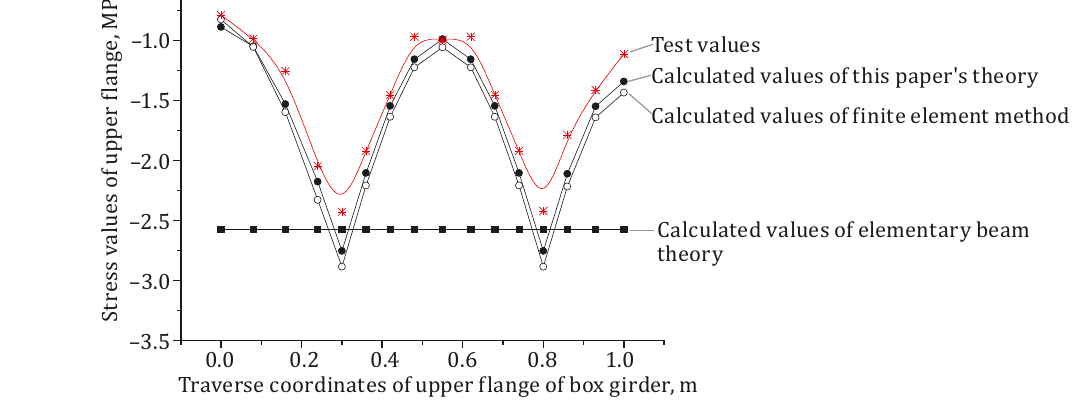
Figure 10. Stress of upper flange under concentrated load Traverse coordinates of upper flange of box girder, m